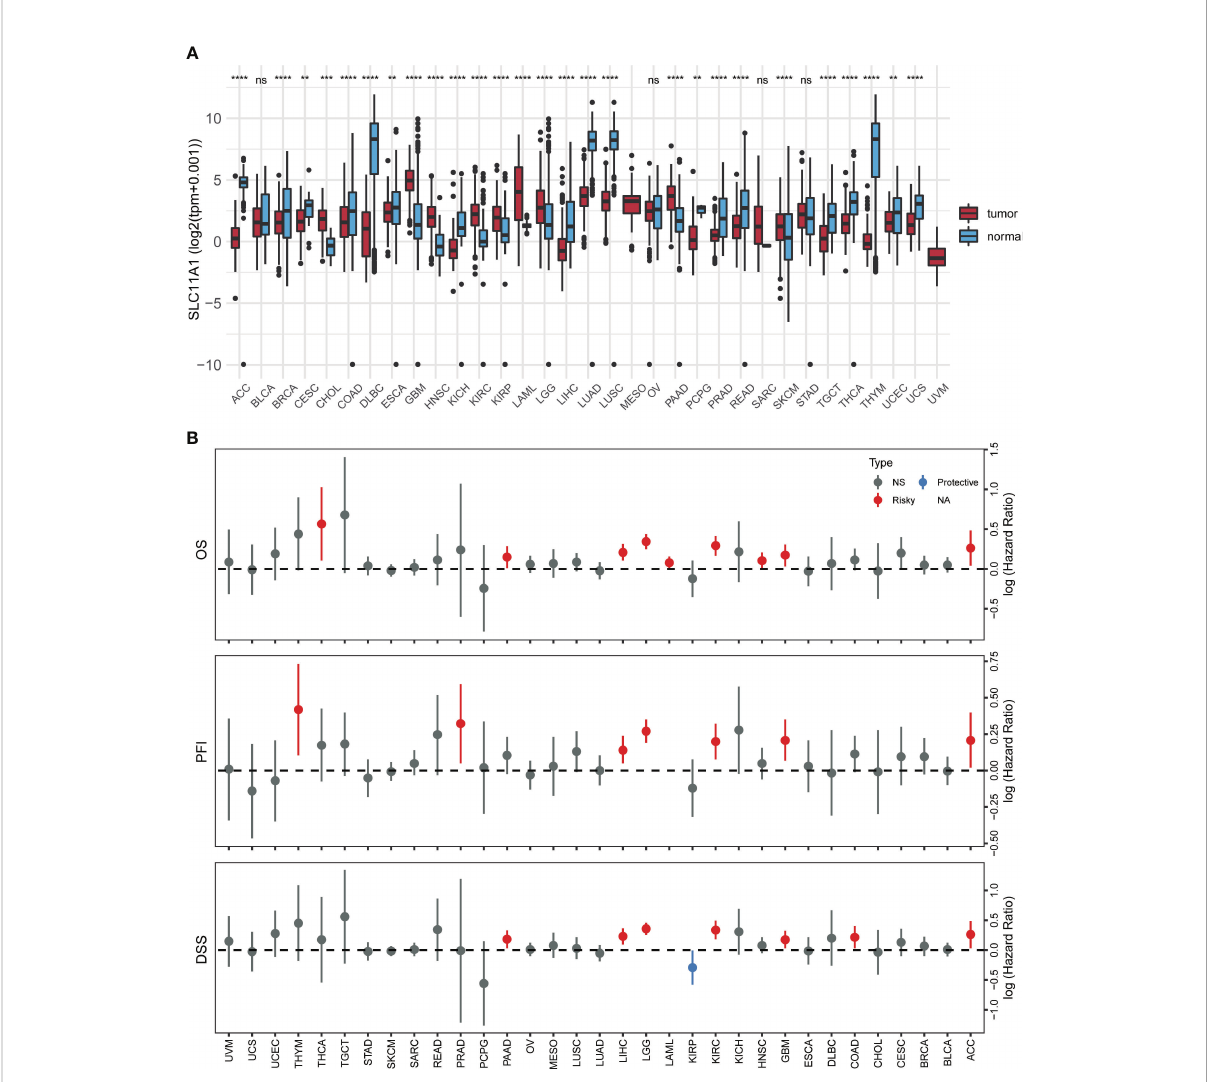
FIGURE 1 Pan-cancer analysis of SLC11A1 expression. (A) UCSCXenaShiny was used to visualize SLC11A1 expression in the cancer genome atlas (TCGA) pan-cancer datasets. (B) Risk plot of correlation SLC11A1 with OS, PFI, DSS (red represents HR > 1(risky) and P value < 0.05; blue represents HR < 1 (protective) and P value < 0.05; grey represents no statistical signi fi cance). **,P < 0.01; ***,P < 0.001; ****,P < 0.0001, ns = no signi fi cance (Wilcoxon